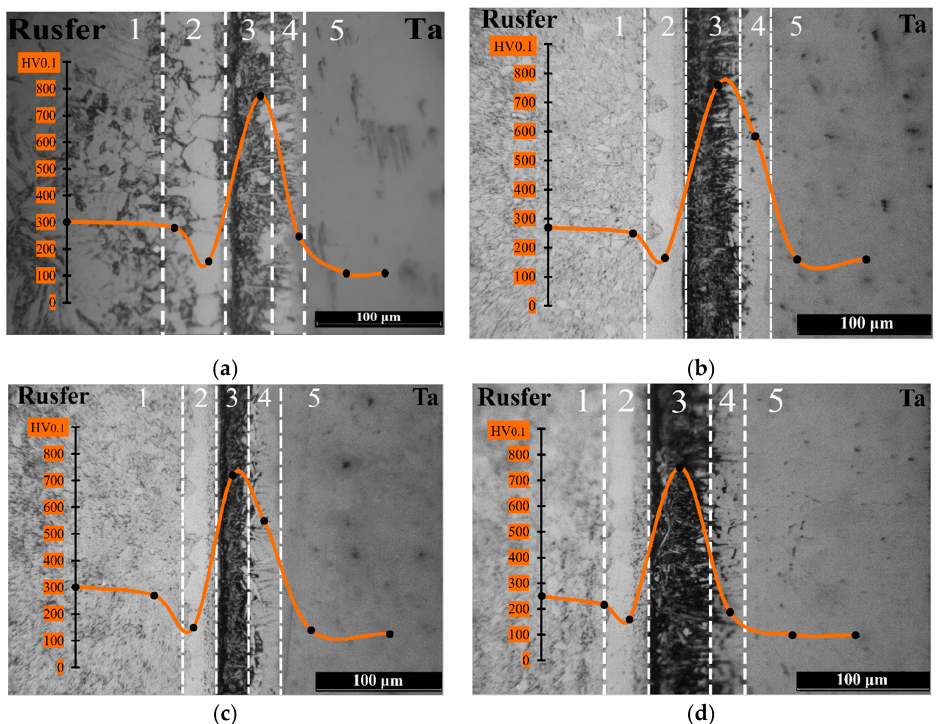
Figure 13. Optical image with microhardness profiles of Rusfer/ TiZr4Be/Ta seam after thermocycling test: ( a )—as-joined, ( b )—50 thermocycles, ( c )—100 thermocycles, ( d )—200 thermocycles.